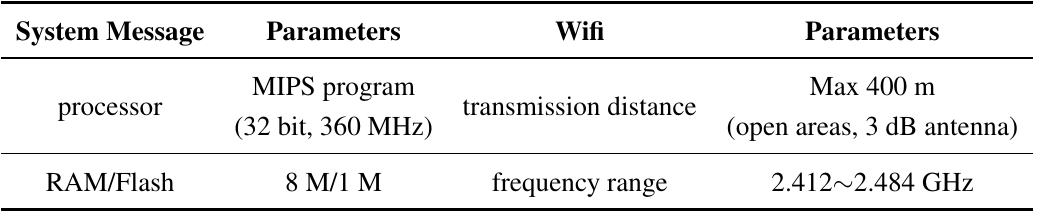
Table 1. Parameters of base